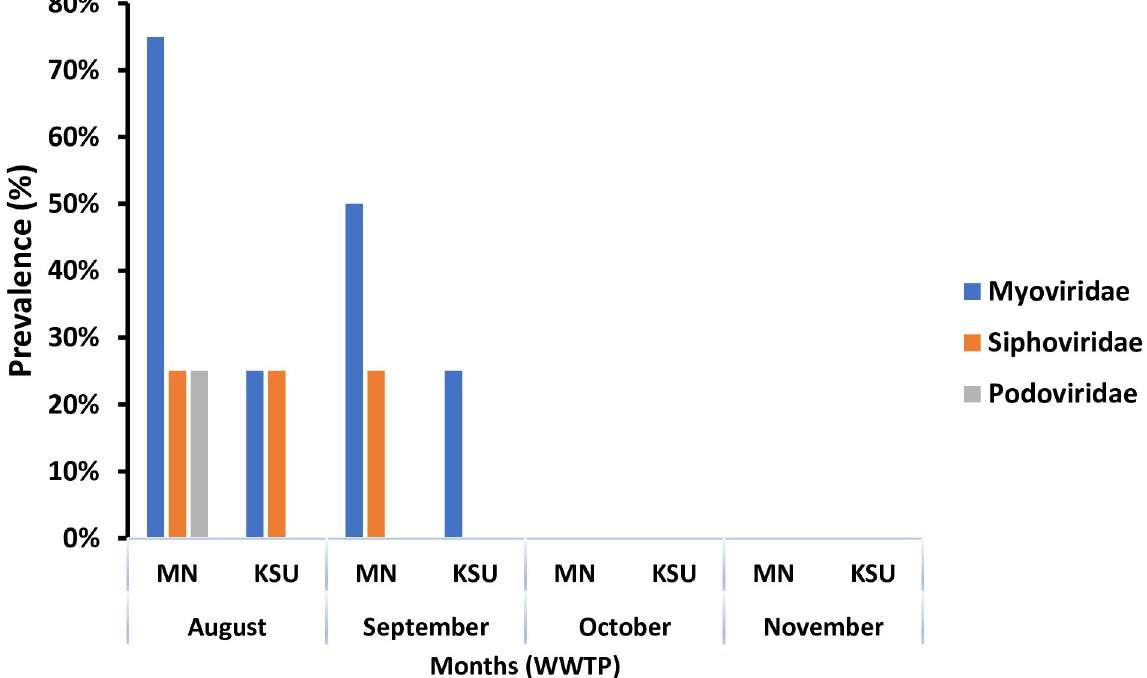
Fig 4. Temporal prevalence of phage families in WWTPs during four-month